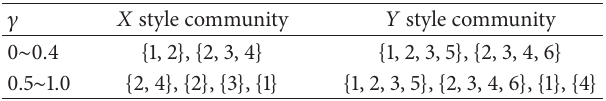
Table 3: An example of getting different-scale communities by adjusting 𝛾 with step length